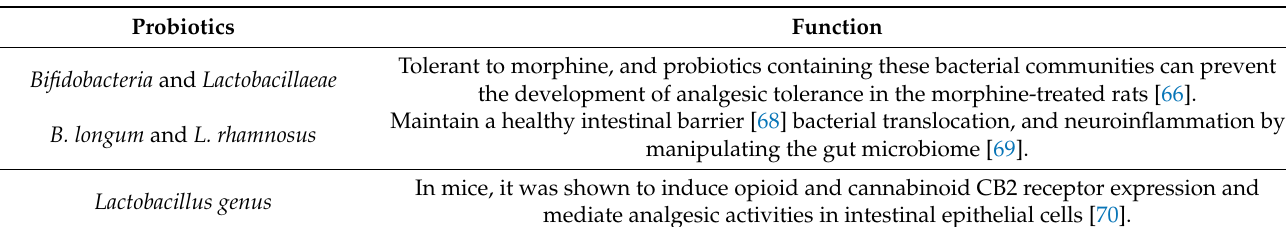
Table 1. Probiotics and their